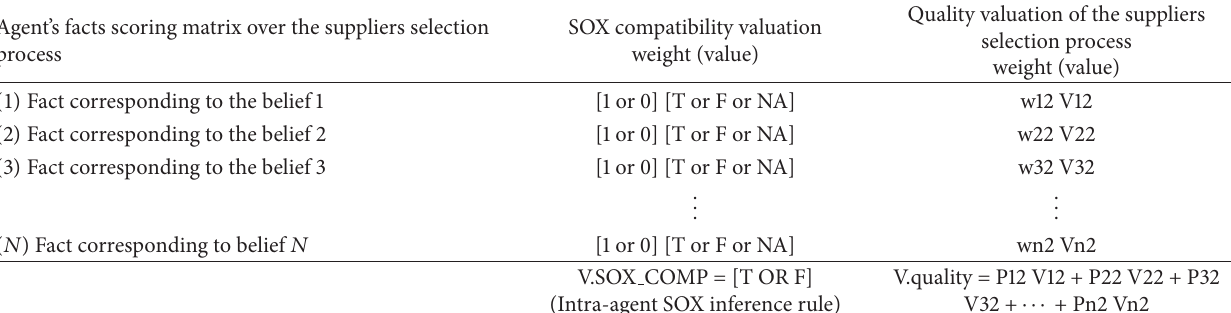
Table 12: Facts Scoring